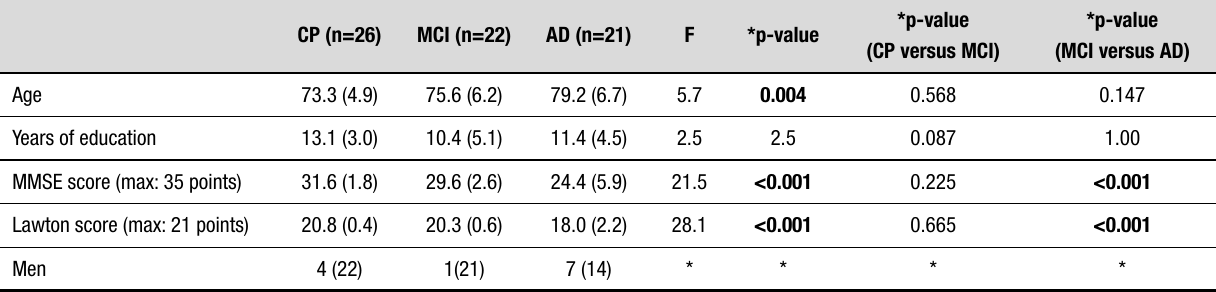
*MMSE: Mini-Mental State Examination; CP: Control Participants; MCI: mild cognitive impairment; AD: Alzheimer’s